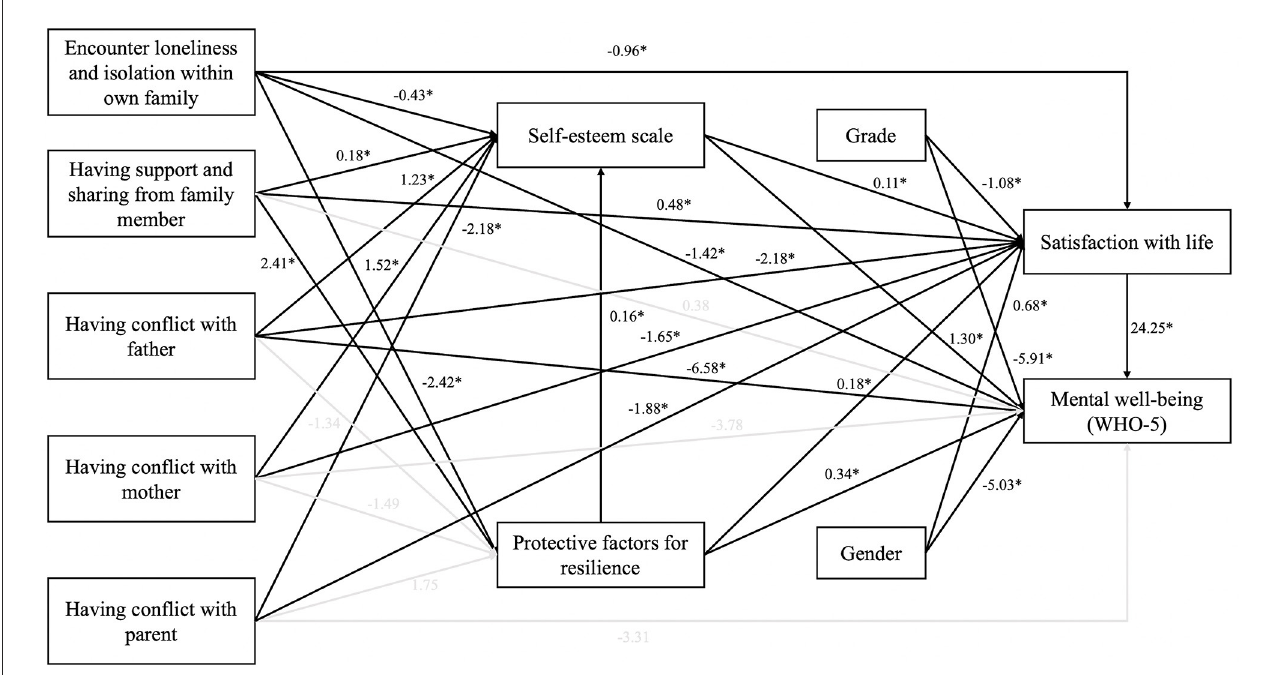
TABLE 5 Indirect effect for relationship between some characteristics and satisfaction with life as well as mental wellbeing mediated by self-esteem and protective factors for resilience. Pathways Indirect